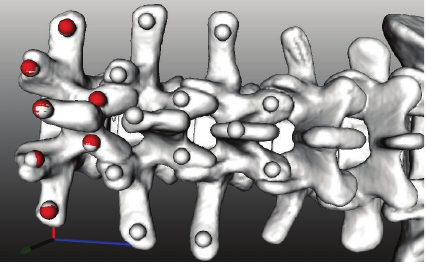
Figure 10: The graphic illustration of the registration result of the seven